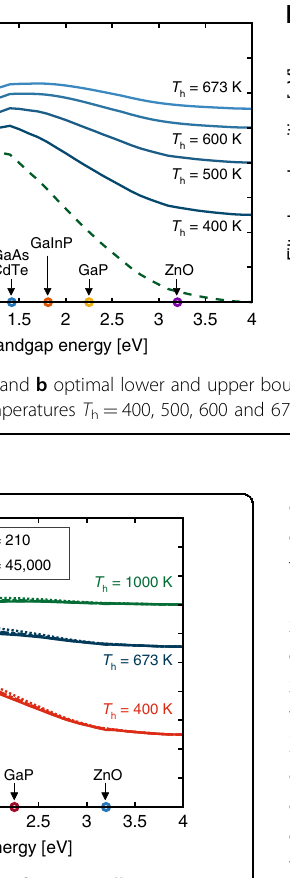
different PV materials). The selection of the PV material has a slight in fl uence (only 7%) on the total effective ef fi ciency limit of SSPVT collectors when T indicated in Fig. 7a.